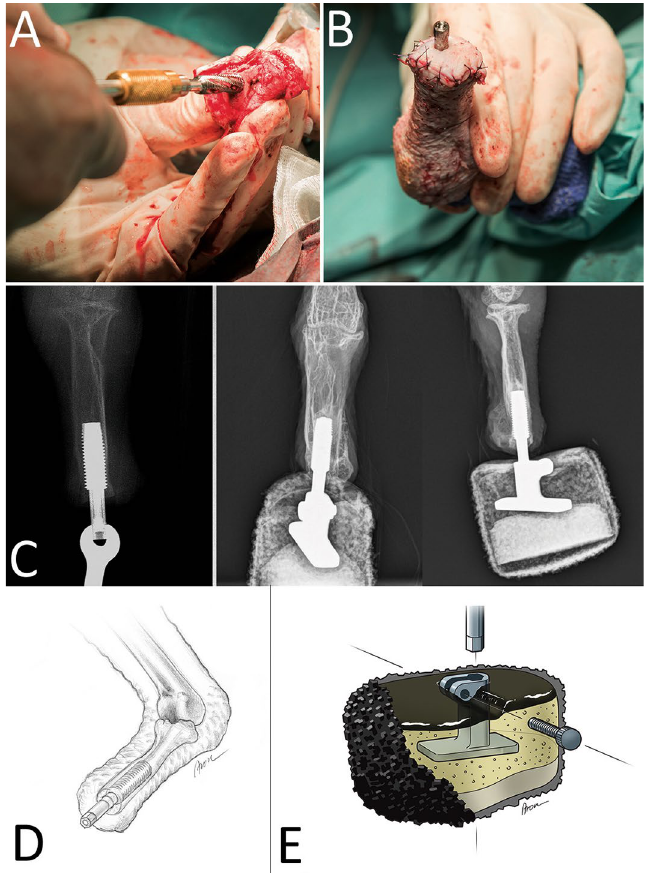
Figure 3. Concept of osseointegration in the vulture. ( A ) Implantation of the osseoimplant after osteotomy with a specialized drilling device. ( B ) The revised stump with osseoimplant piercing through a skin opening after wound closure. Copyright by Felix Gantenbein. ( C ) Radiographs of the implant during surgery (left, dorsoplantar view), and after the surgery with the mounted prosthesis (middle/dorsoplantar view and right/ mediolateral view). ( D ) Schematic drawing of the osseoimplant after surgery, located in the medullary cavity. ( E ) Design of the prosthetic attachment to the bone implant. Various layers of cohesive soft materials are located around the central metal attachment to the prosthesis. On the prosthesis’ surface a rough rubber surface provides traction and